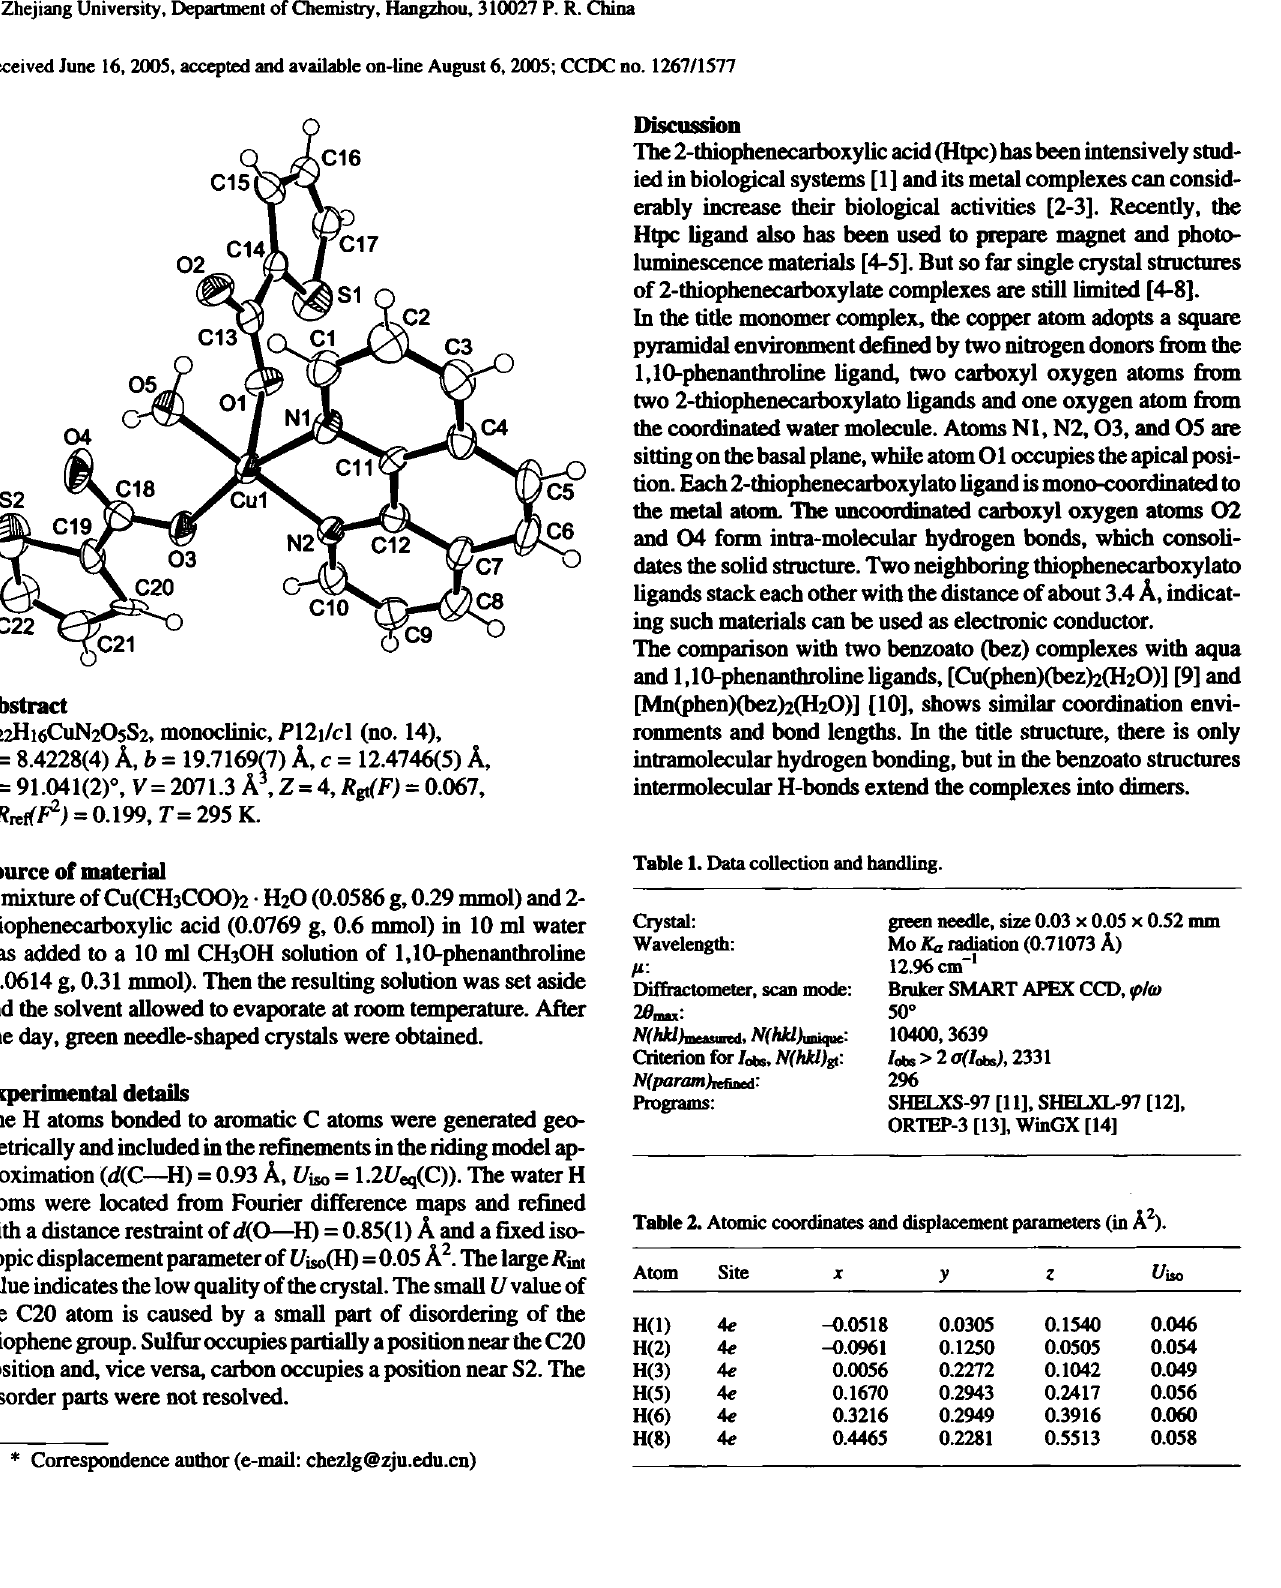
Table 2. Atomic coordinates and displacement parameters (in A 2